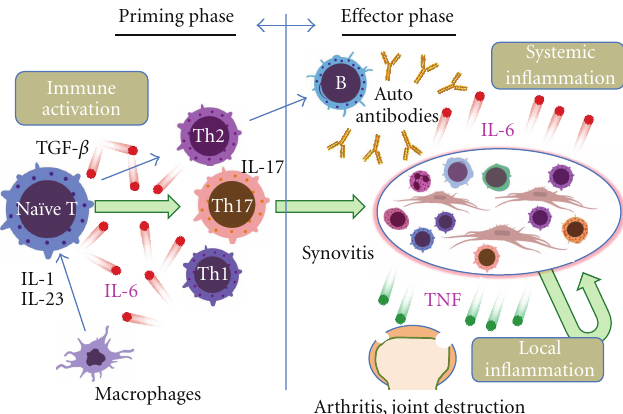
Figure 1: Pathological role of IL-6 in rheumatoid arthritis. IL-6 is important for development of Th17 and induction of autoantibodies such as rheumatoid factor. Activated Th17 cells and autoantibodies generate pannus in combination with activated fibroblastic synoviocytes, macrophages, and lymphocytes. Inflamed synovitis such as pannus is a major source of inflammatory cytokines including IL-6, and systemic inflammation (resulting in production of acute phase protein, anemia, and fatigue) is mainly mediated by IL-6. Tumor necrosis factor (TNF) plays a major role in the progression of local types of inflammation (arthritis) such as arthralgia, swelling, and joint destruction but plays a minor role during the priming